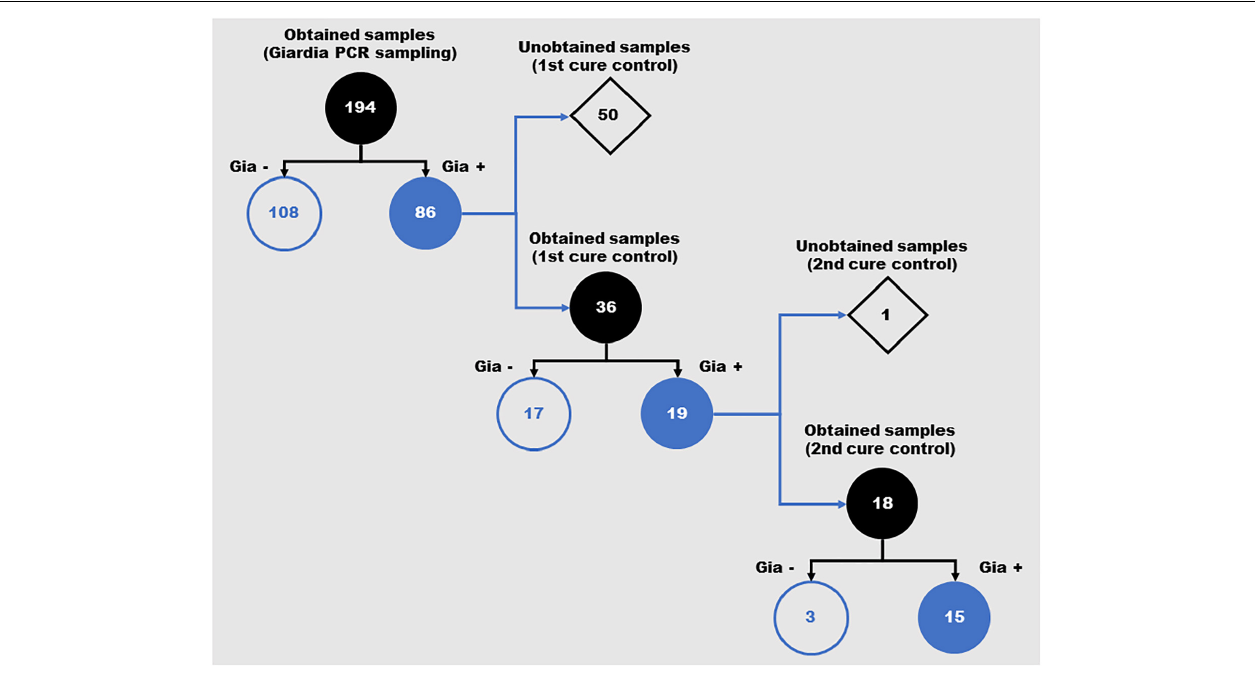
FIGURE 1 | Schematic representation of the positivity for Giardia lamblia in feces samples from children over the different periods of the study. Number of samples obtained during the three evaluation moments of the study ( Giardia PCR sampling, 1st cure control and 2nd cure control). Gia–: Samples with negative diagnosis for Giardia by PCR; Gia+: Samples with positive diagnosis for Giardia by